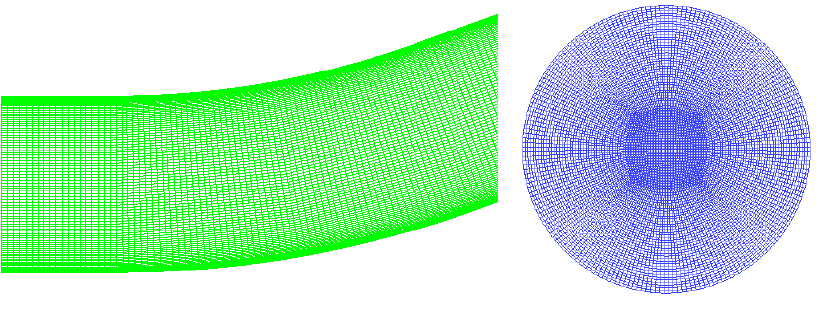
Processes 2020 , 8 , x FOR PEER REVIEW